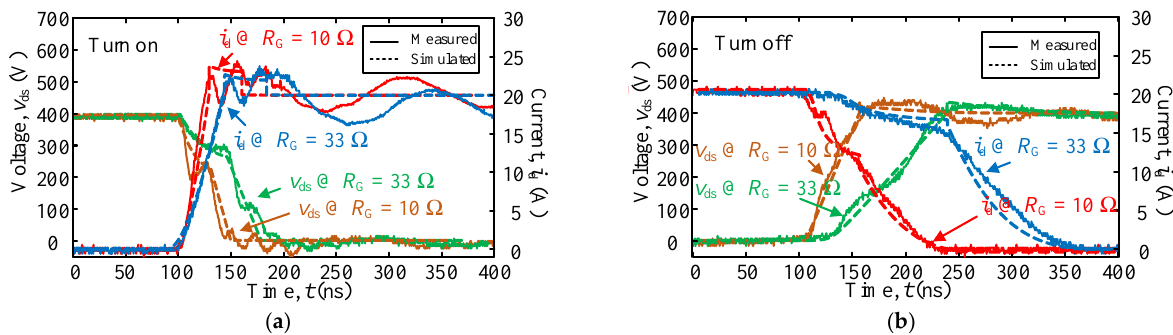
Figure 12. Switching waveforms of Si MOSFET with SiC SBD ( a ) turn-on; ( b ) turn-off; @ 400 V,20 A,25 ℃ .